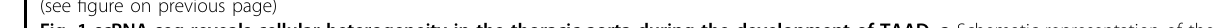
Fig. 1 scRNA-seq reveals cellular heterogeneity in the thoracic aorta during the development of TAAD. a Schematic representation of the scRNA-seq procedure. The ascending aorta and aortic arch were collected at three time points during the induction, i.e., after 7, 14, and 21 days of BAPN or vehicle (drinking water) administration. Tissues from six mice were pooled for each time point for scRNA-seq. CTRL, control. b Unbiased clustering of 61,826 cells from all six samples reveals 24 cellular clusters. The number in the parenthesis indicates the cell count. c Hierarchical clustering of the clusters based on the average expression of the 2000 most variable genes. d Expression of the established marker genes speci fi c for each lineage in each cluster. e Representative molecular signatures for each cell cluster. The area of the circles indicates the proportion of cells expressing the gene, and the color intensity re fl ects the expression intensity. EDO, endothelial cell; FB, fi broblast; MAC, macrophage; PCD, pericardial cell; SMC, smooth muscle